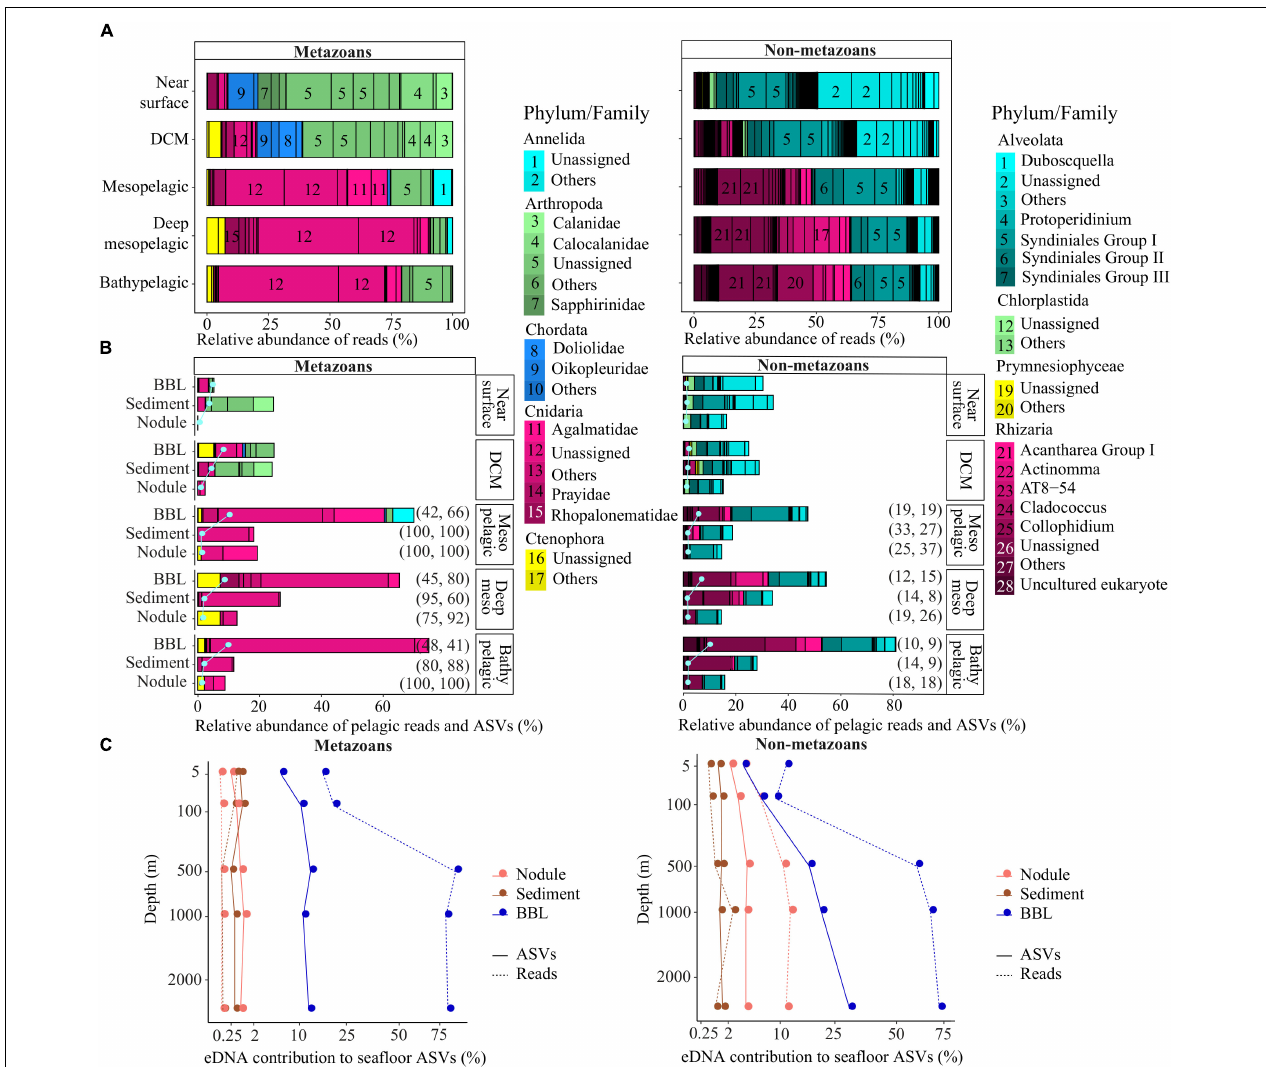
FIGURE 4 | Pelagic eDNA community composition and contribution to diversity at the seafloor. (A) Relative read abundance (bars) of phyla and families per pelagic depth zone within each deep ocean habitat (abyssal plains, seamounts). (B) Relative abundance of pelagic reads (bars) and pelagic ASVs (pale gray dots and lines) that also were sampled in abyssal sediment, nodule or BBL seawater samples, plotted relative to the diversity sampled in the water column per pelagic depth zone (pelagic perspective). The percent of pelagic ASVs and associated reads concurrently found in the epipelagic are indicated on the right side of the bars, in parentheses. Families with marginal relative abundance were combined and designated as “Others”. (C) Proportion of sediment, nodule or BBL seawater ASVs and reads that were found within each pelagic zone sampled. Plot shows the benthic perspective, or pelagic diversity sampled at the seafloor relative to all diversity sampled at the seafloor. BBL, benthic boundary layer; DCM, deep chlorophyll